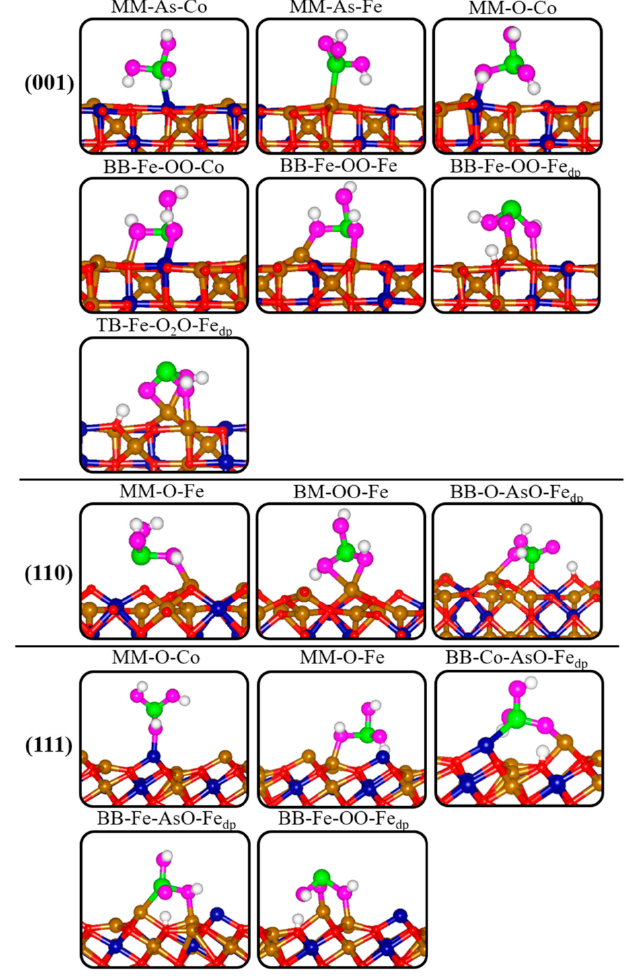
Figure 5. Optimised lowest-energy unique adsorption configurations of H 3 AsO 3 on the dry Fe 2 CoO 4 (001), (110), and (111) surfaces. H 3 AsO 3 molecules enlarged for clarity (Fe = brown, Co = blue, O surf = red, O mol = purple, H = white); dp = deprotonated; MM = monodentate mononuclear; BB = bidentate